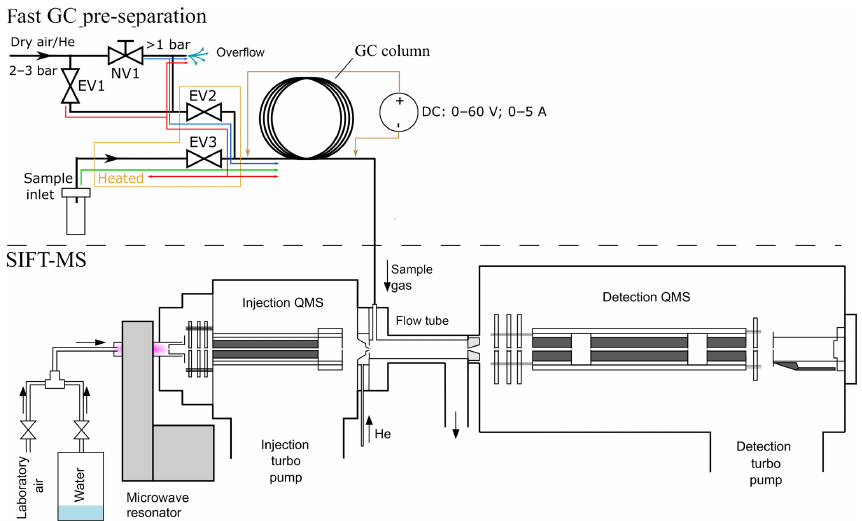
Figure 1. Schematic visualization of the fast GC and SIFT-MS experiment. Coloured lines in the inlet part of the fast CG represent gas flow through the system of valves EV1–3. The blue line traces the “normal mode” regime, the green line represents the “sampling mode” and the red line represents the “cleaning mode”.